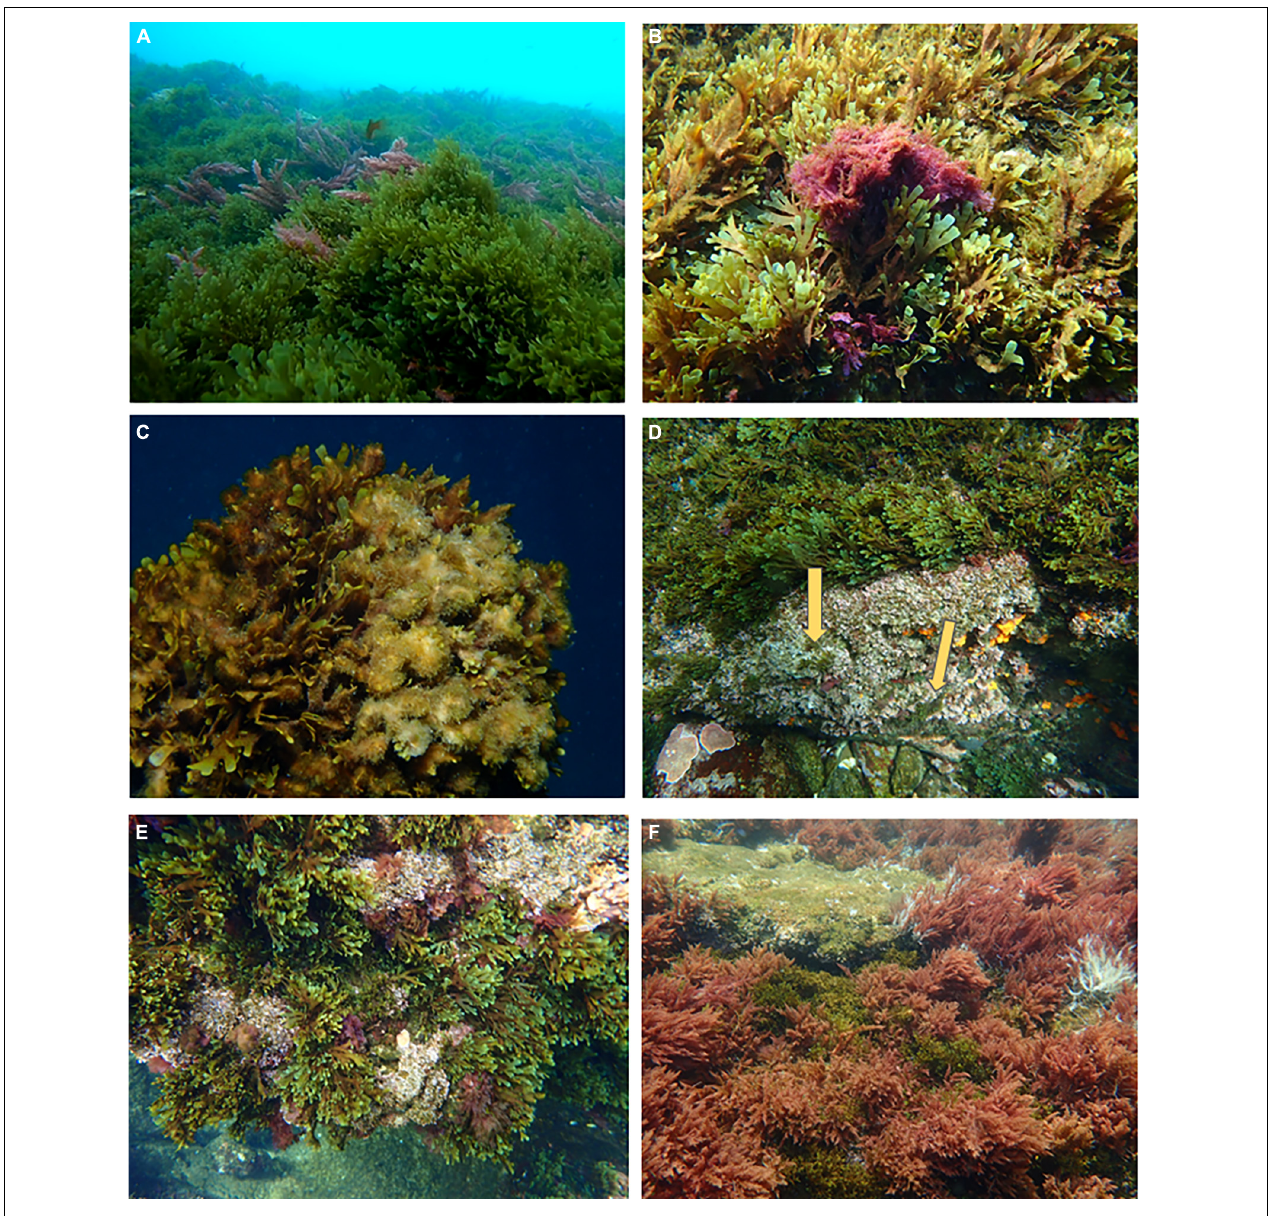
FIGURE 4 | (A) Overgrowth of Asparagopsis armata on Rugulopteryx okamurae in the Strait of Gibraltar (1–5 m depth) after 2017. (B) Overgrowth of Plocamium cartilagineum and (C) generalist algae on R. okamurae . (D) Ellisolandia elongata surrounded by R. okamurae fronds with small specimens already inserted on E. elongata specimens (arrows). (E) Expansion of R. okamurae in detriment of E. elongata in rocky illuminated habitats. (F) Asparagopsis armata laterally compressed by R. okamurae before